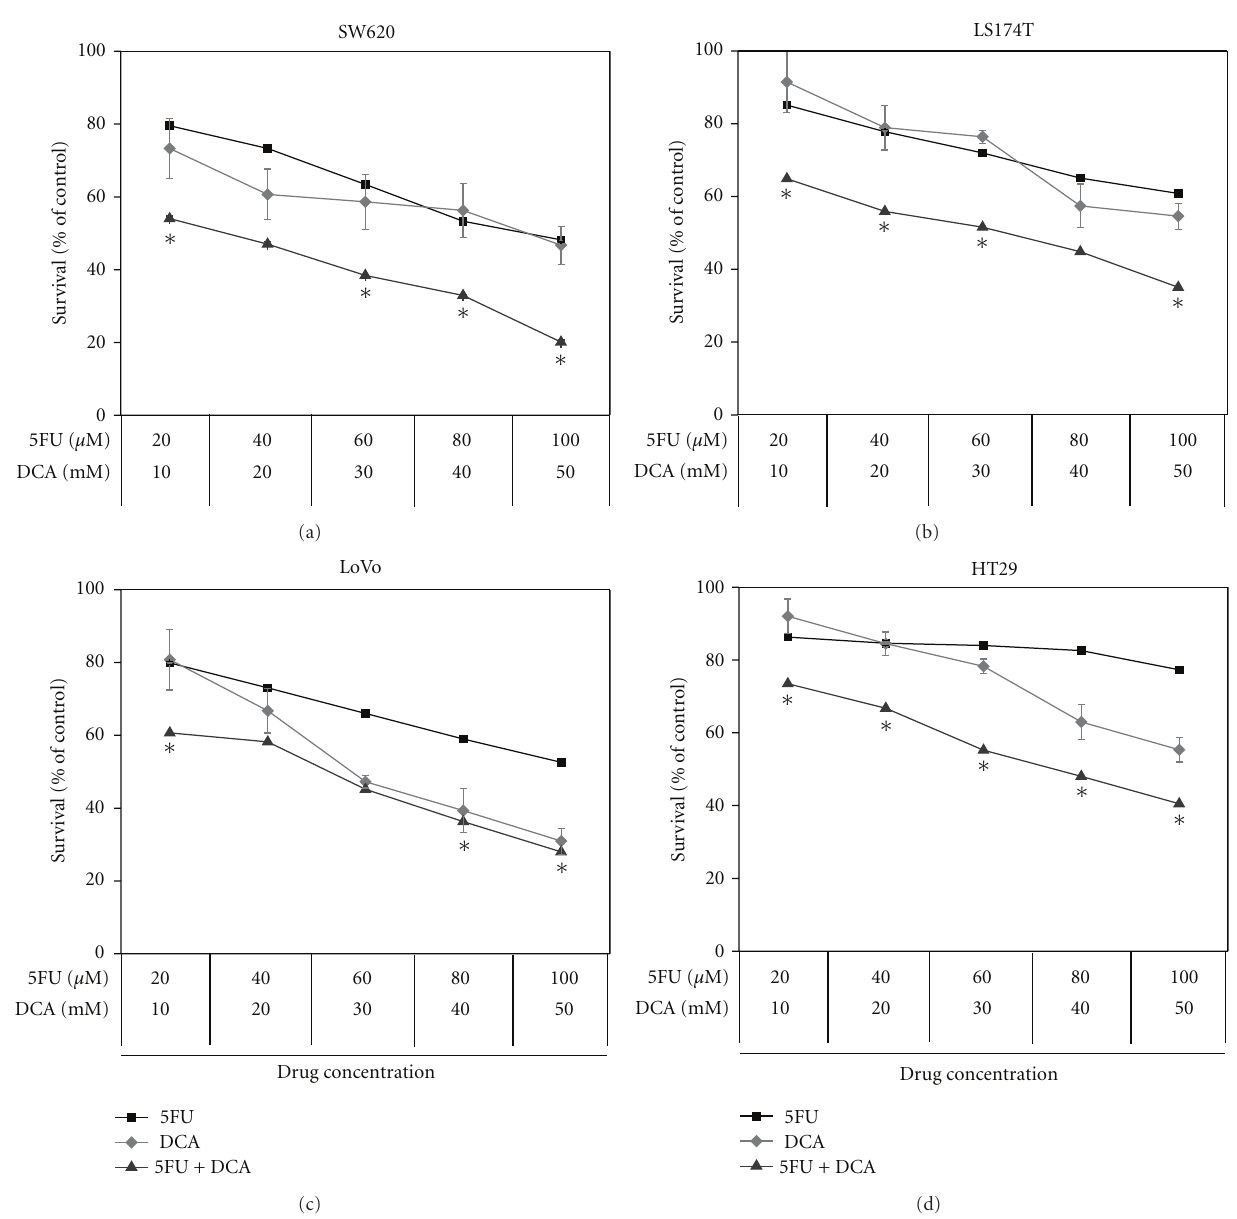
Figure 1: Viability of four CRC cell lines in response to treatment with dichloroacetate (DCA) and 5-fluorouracil (5-FU). The viability of SW620, LoVo, LS174t, and HT29 was decreased significantly with di ff erent concentration of 5-FU and DCA alone or in combination. Each experiment was performed in triplicate; ∗ P < .